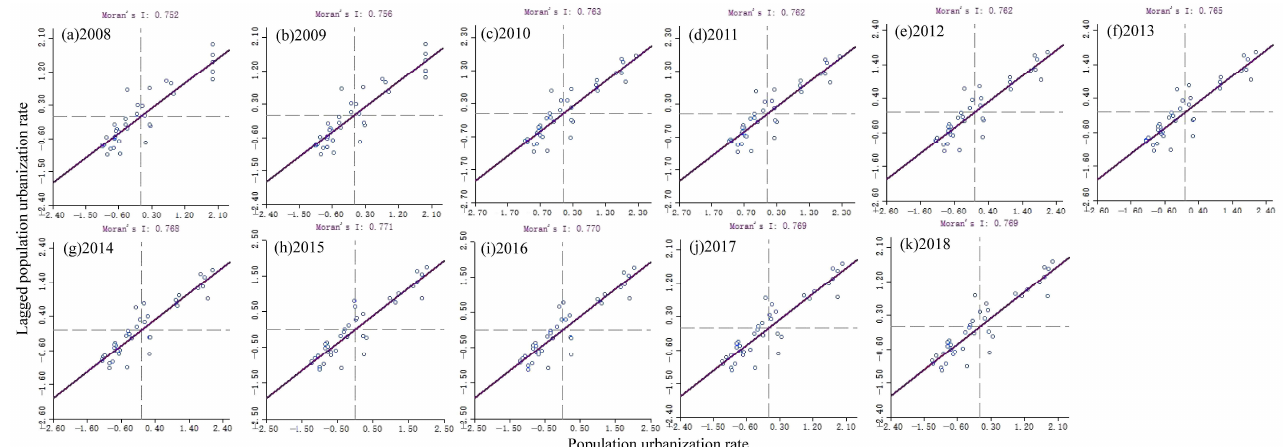
Figure 11. The results of the Spatial Correlation Analysis of PU. ( a – k ) Moran Index of PU during 2008–2018.